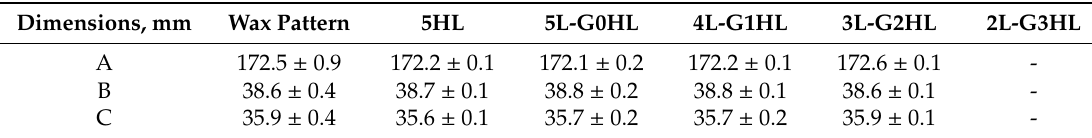
Table 3. Dimensions and tolerance of